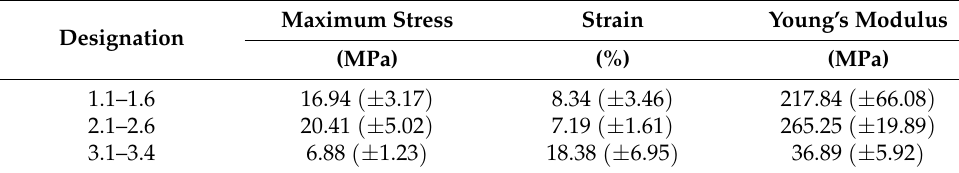
Table 2. Average tensile properties of tested fabrics.